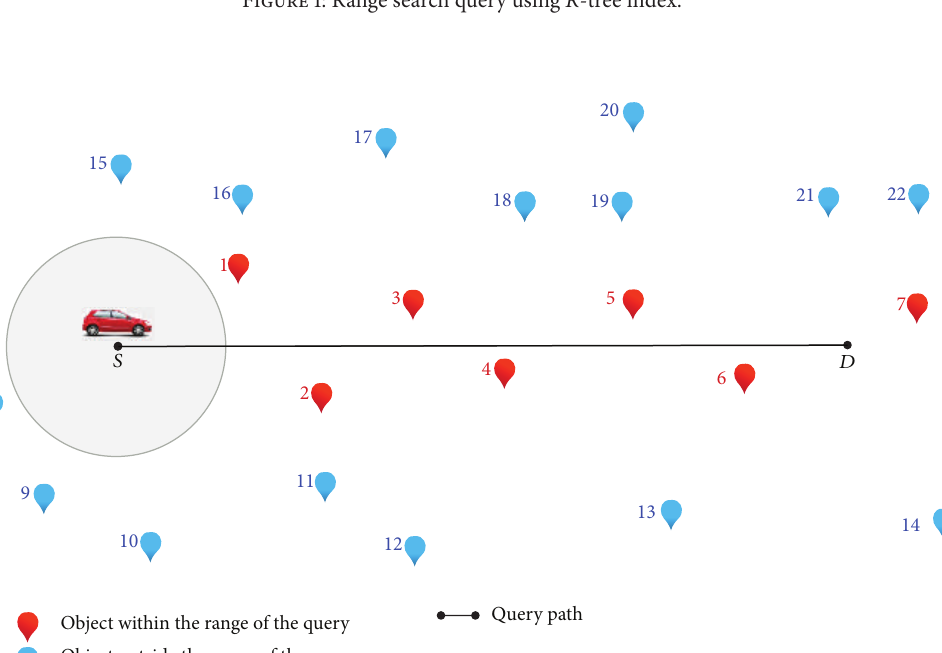
Figure 1: Range search query using 𝑅 -tree index.